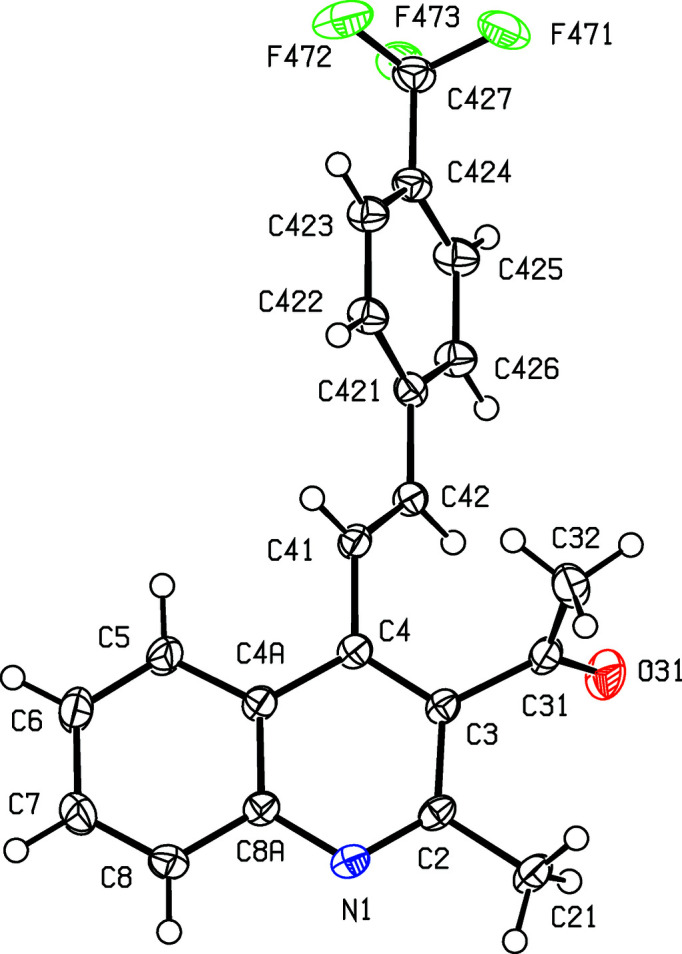
The mol­ecular structure of com­pound (III), showing the atom-labelling scheme. Displacement ellipsoids are drawn at the 50% probability level.